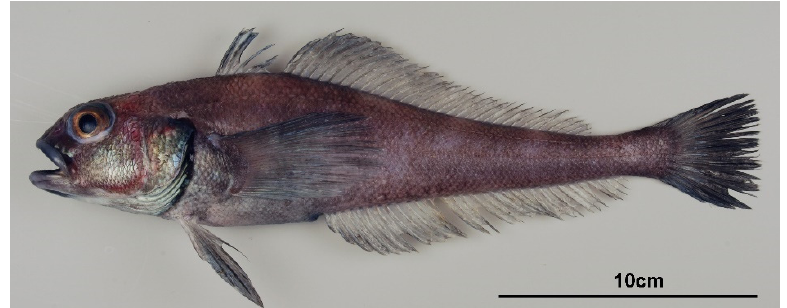
Figure 1. T. loennbergii from the Ross Sea, Antarctica.